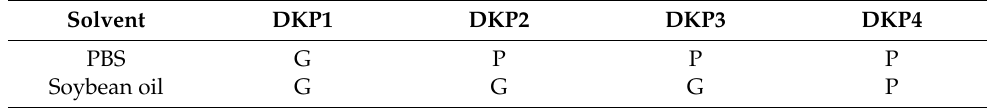
Table 3. Gelation tests for DKPs 1–4. P = precipitate. G =